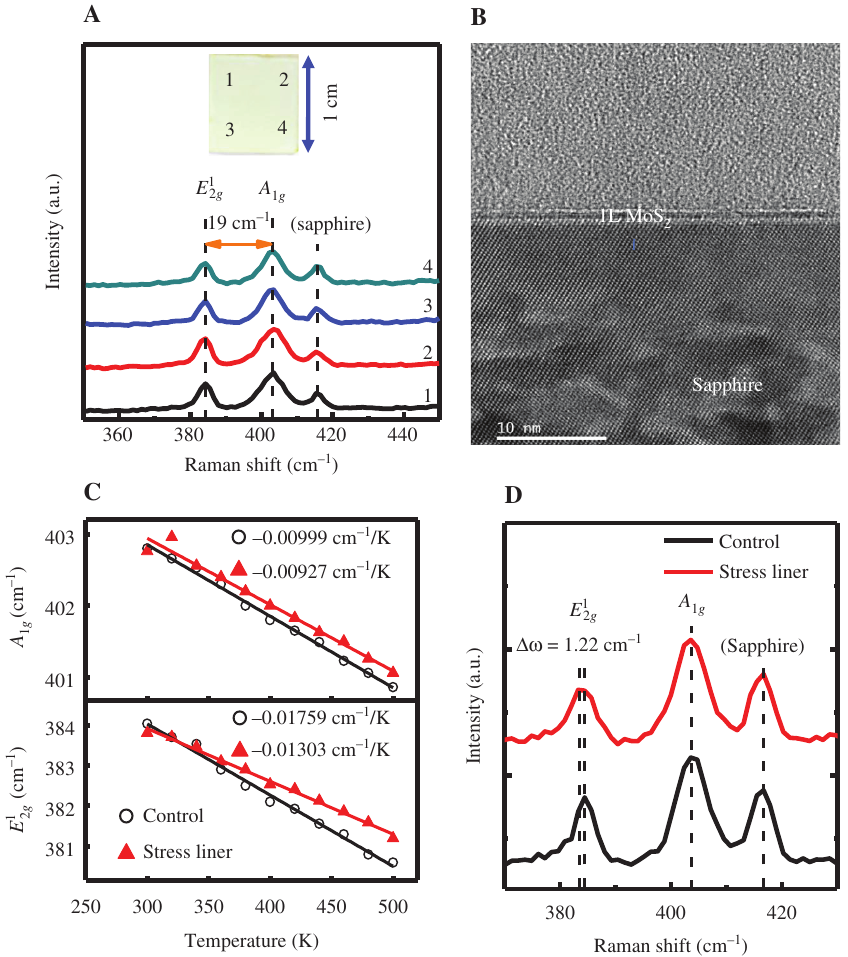
with and without oxide stress liner. Figure 1: Material characterization of MoS 2 (A) Raman spectra of a monolayer MoS sample grown on a 1 cm × 1 cm sapphire substrate from the four locations (indicated by the 1, 2, 3, 2 E and A and 4 in the inset). The distance between the 1 modes is 19 cm − 2 . (B) Cross-sectional transmission electron microscopy (TEM) image 2 g 1 g E and A of the monolayer MoS /sapphire sample. (C) 1 Raman modes of control and stress liner samples as a function of temperature 2 g 2 1 g including a linear fit. (D) Raman spectra of the control and stress liner samples at room